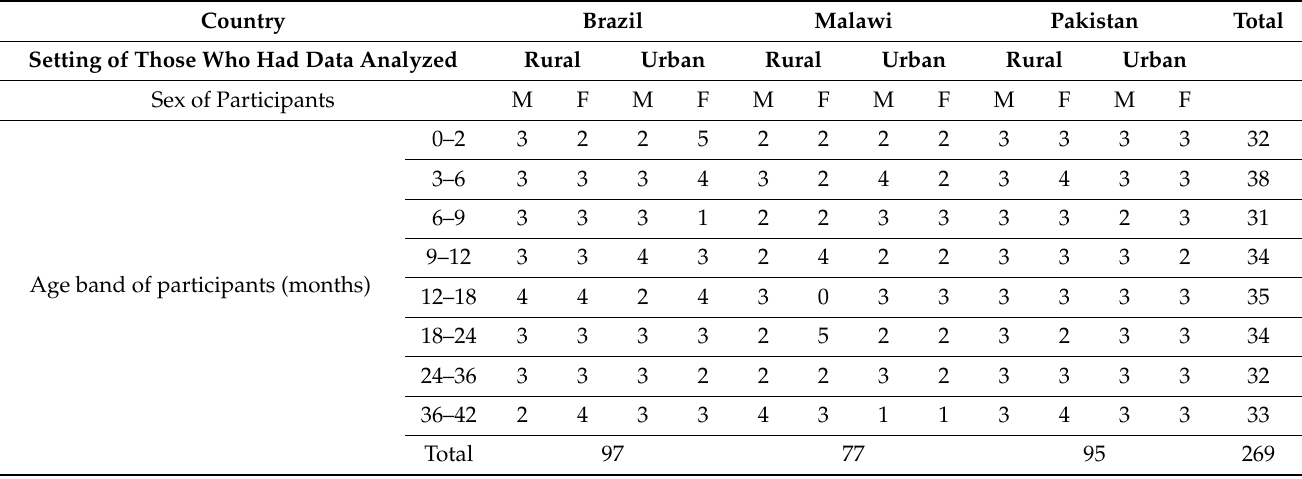
Table 1. Table of children recruited and included in the validation of the Indicators of Young Child Development (IYCD). Country Brazil Malawi Pakistan Total Setting of Those Who Had Data Analyzed Rural Urban Rural Urban Rural Urban Sex of Participants M F M F